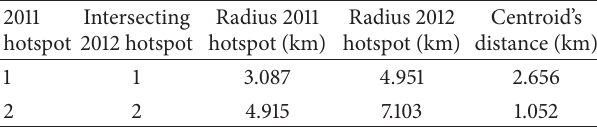
Table 3: Nasal polyposis—comparison results of the hotspots obtained for the years 2011 and 2012.